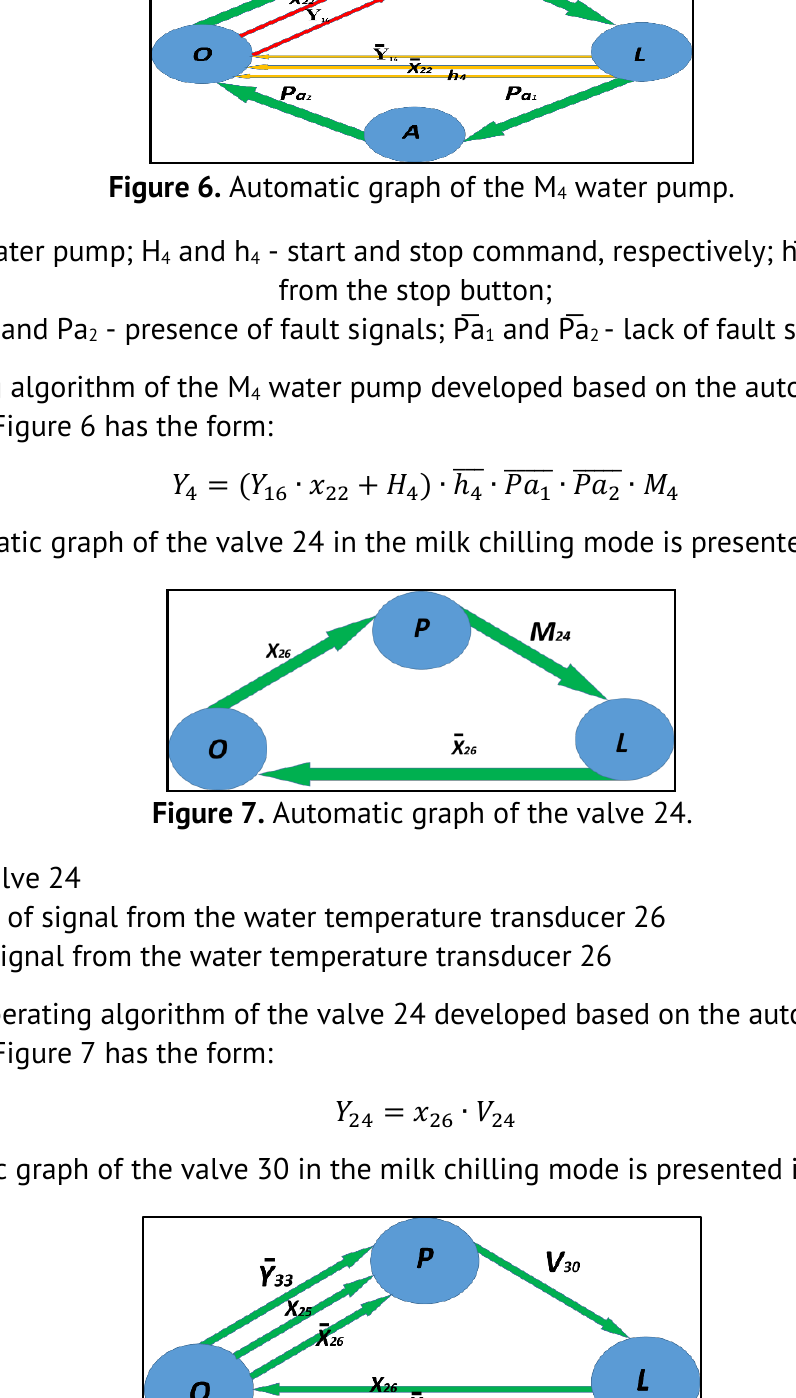
Figure 6. Automatic graph of the M